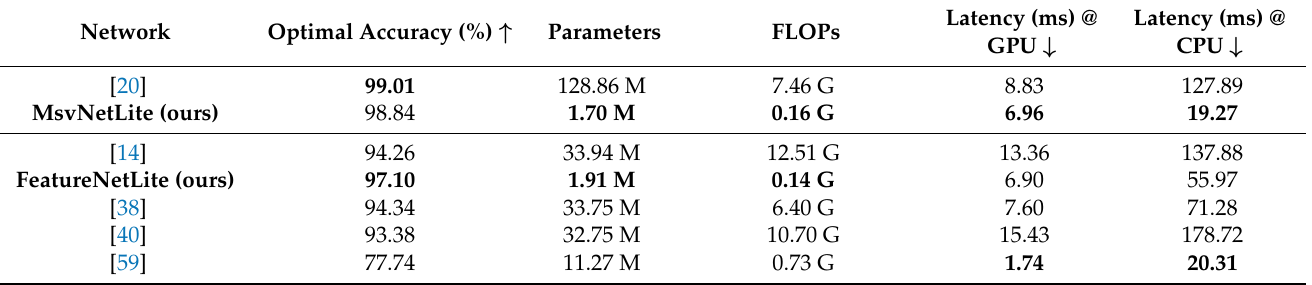
Table 4. The comparison of optimal recognition accuracy (%), network size, and average inference latency with different approaches. The bold number is the best result in each